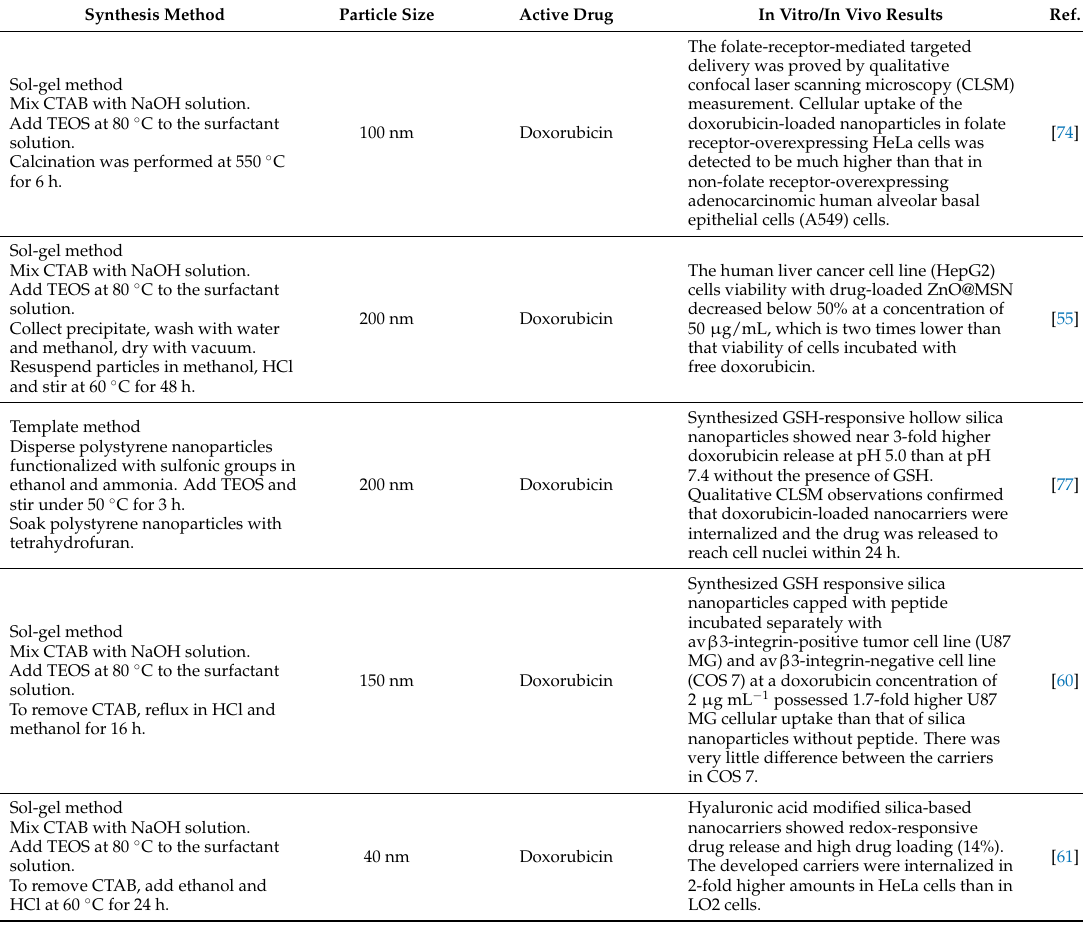
Table 1. Recently studied silica-based drug delivery systems. Synthesis Method Particle Size Active